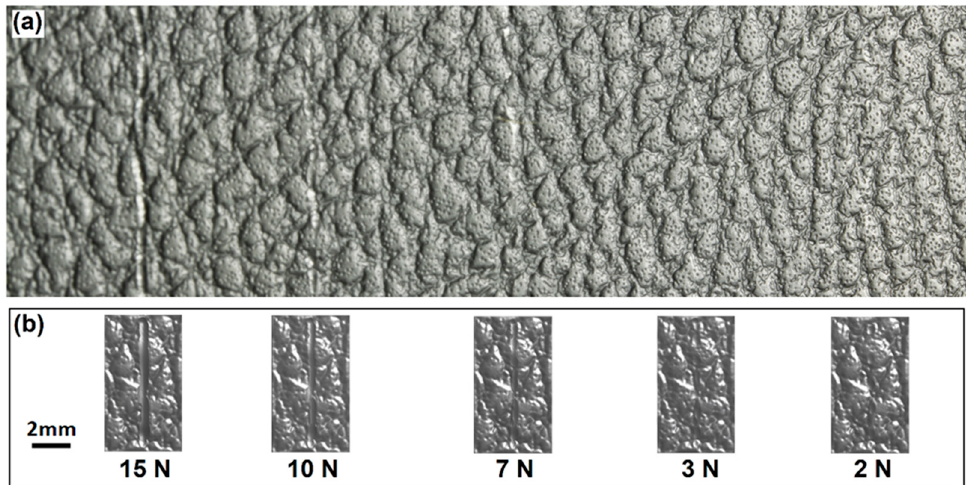
Figure 9. Images of scratches produced under different forces on the CB texture. ( a ) experiment and ( b ) simulation.